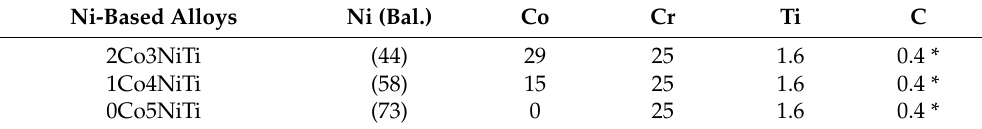
Table 2. Chemical compositions of the three Ni-richest alloys (confirmed by EDS full frame analysis; wt.%).